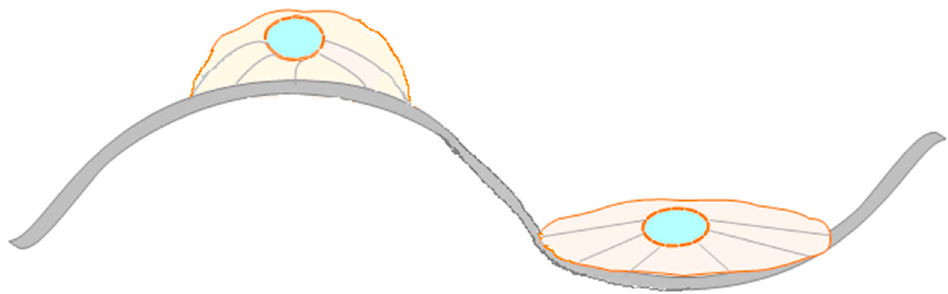
Figure 3. Illustration of the reorganization of cell actin skeleton structures, shape and attachment according to surface according to surface morphology.